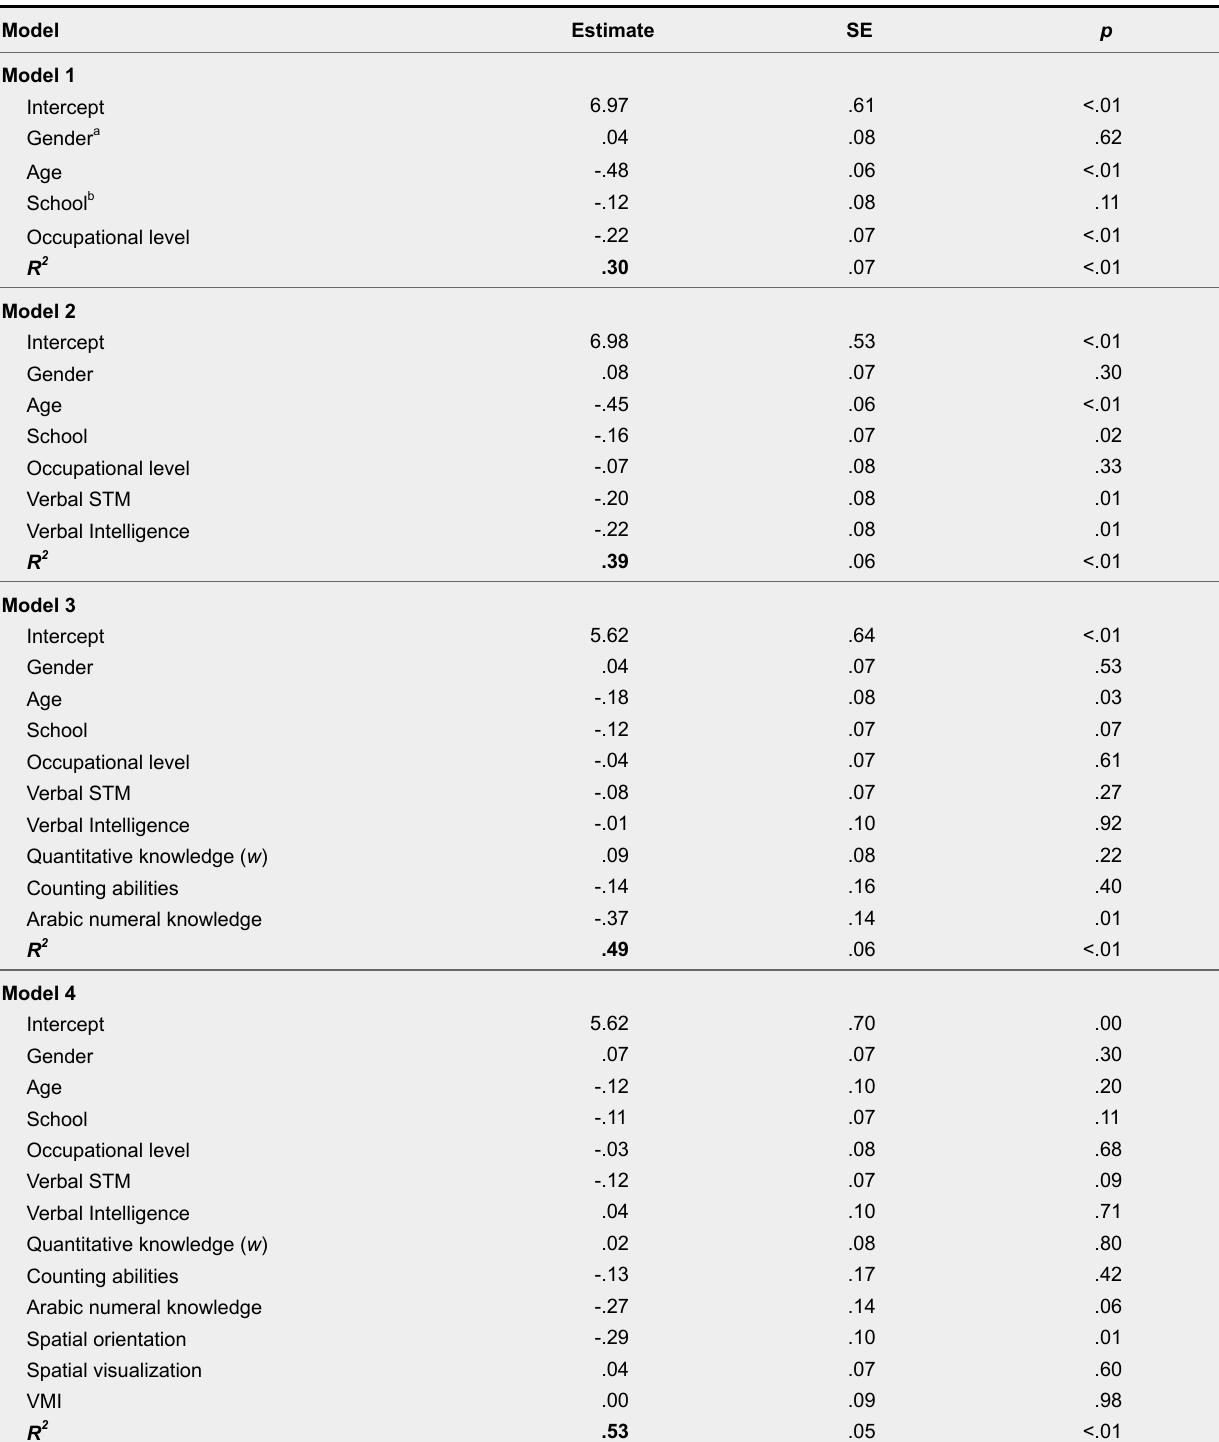
Standardized Parameter Estimates of the Different Models Predicting Performance in Number Line